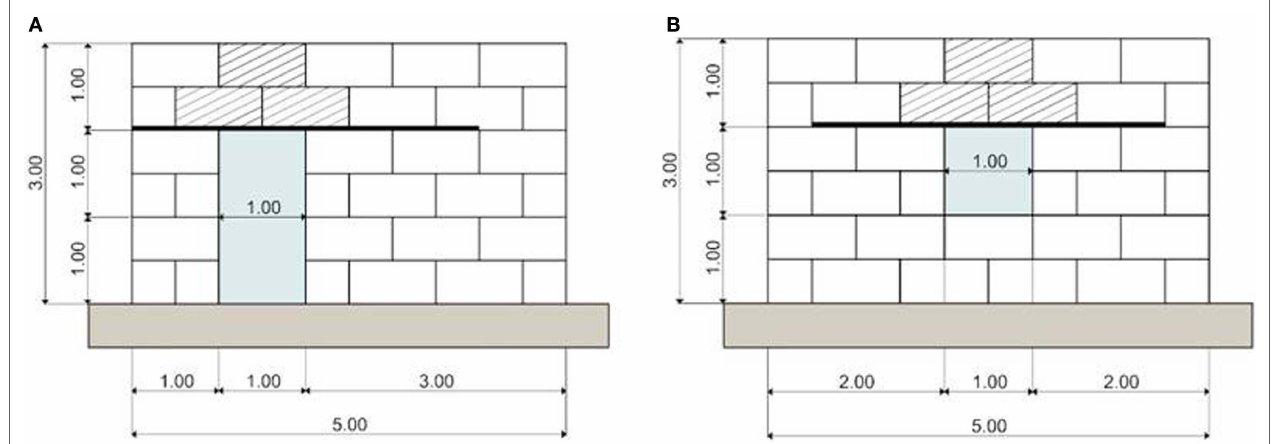
FIGURE 3 | Details and dimensions of walls with openings for (A) door and (B) window.